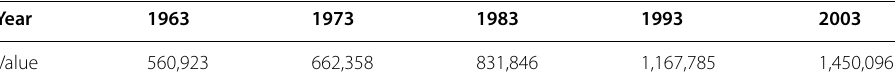
Table 2 Value of agricultural output (in Rs. millions) 44 crops: India. Source : Government of India, Area and Production of Principal Crops in India (various issues), Ministry of Agri- culture